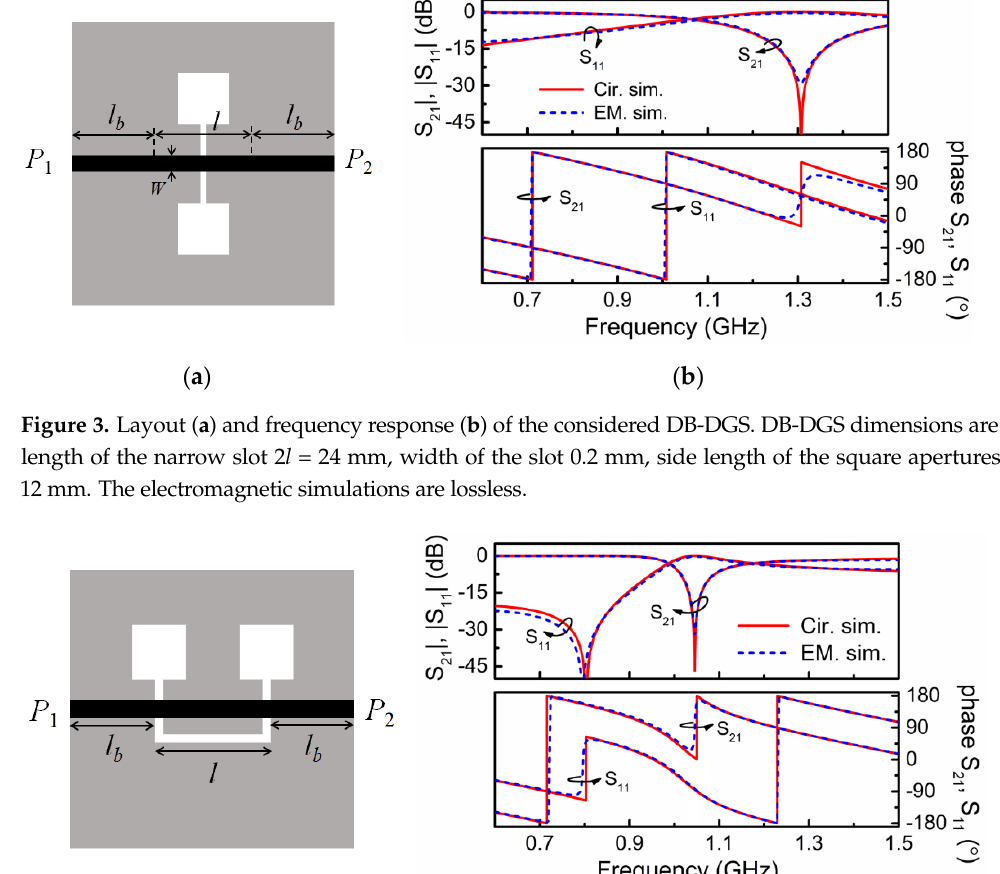
Figure 5. Circuit model of the microstrip line loaded with the folded and rotated (90°) DB-DGS resonator.